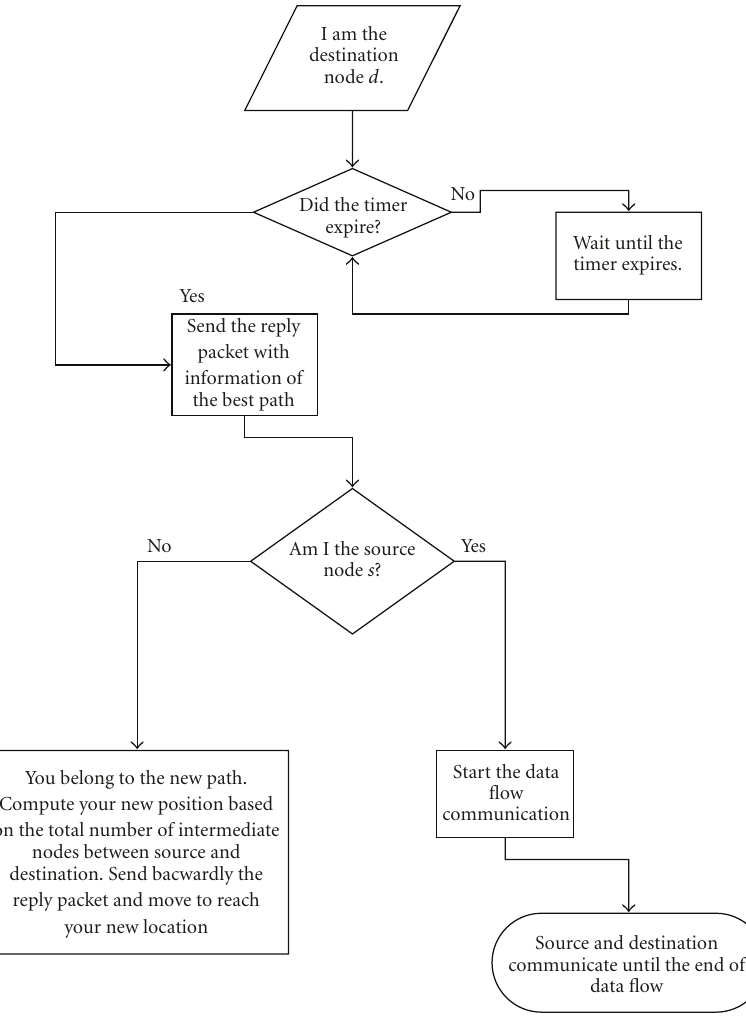
Figure 3: Reply phase of